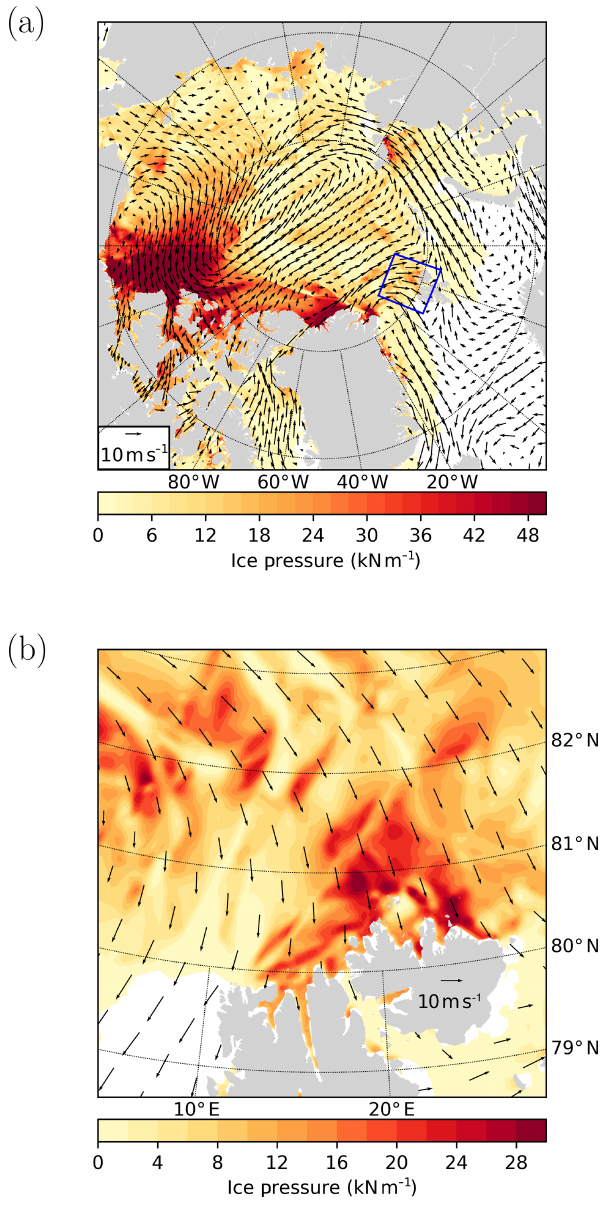
Figure 1. A 24h forecast of the sea ice pressure (kNm − 1 ) and of the surface winds (ms − 1 ) from the Canadian Arctic Prediction System (CAPS). The forecast was initiated at 00:00UTC on 29 April 2020. Almost all of the domain is shown in (a) , while (b) is a subset of the domain located in the region of Svalbard (the sub-region is defined by the blue rectangle in a ). Note that the colour scale is not the same for the two